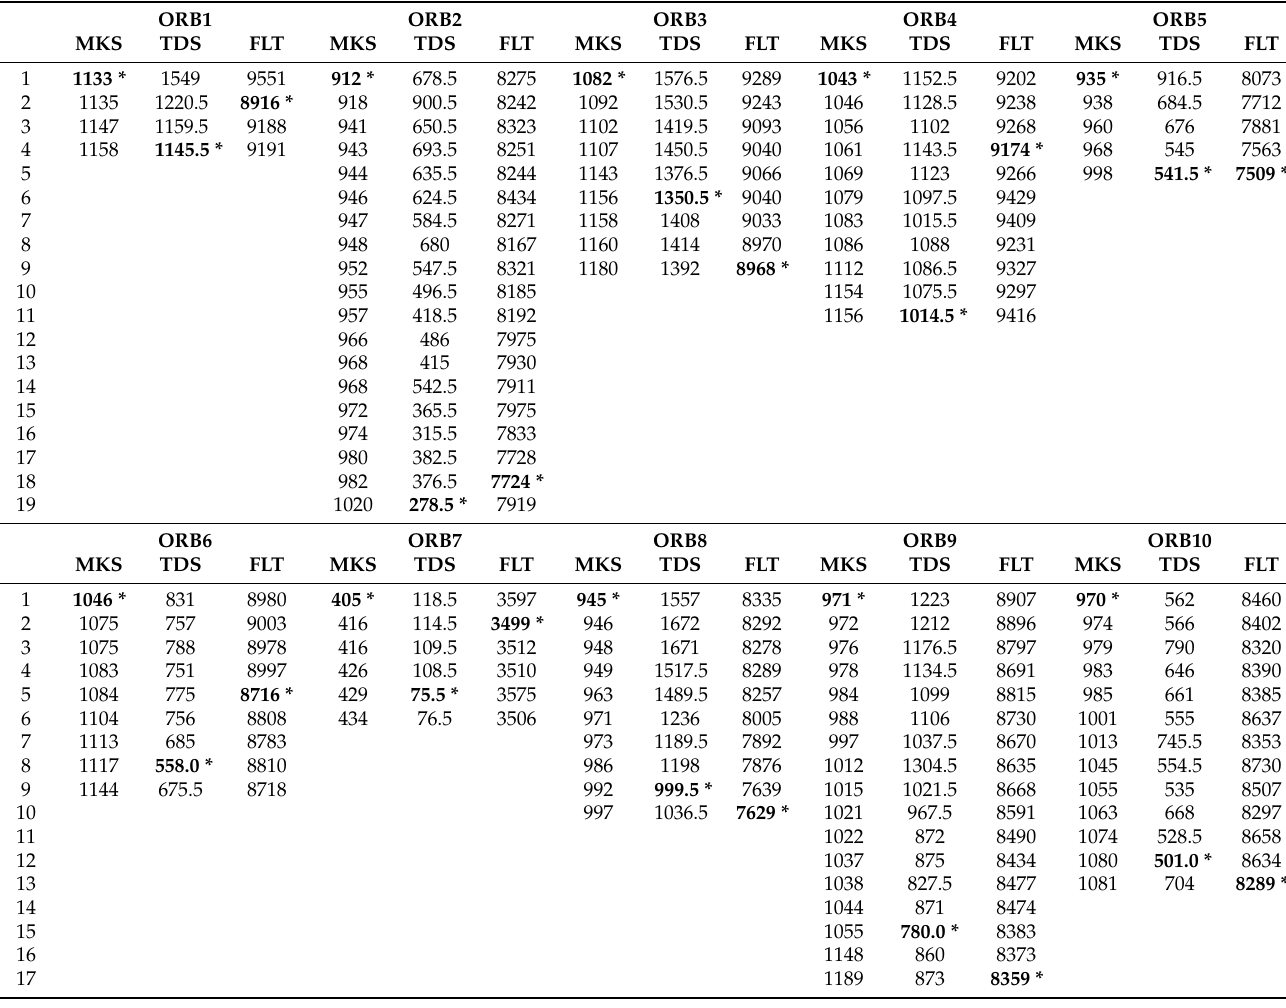
Table A8. Non-dominated solutions obtained by SS/CMOSA for the JSSP instances proposed by [37].